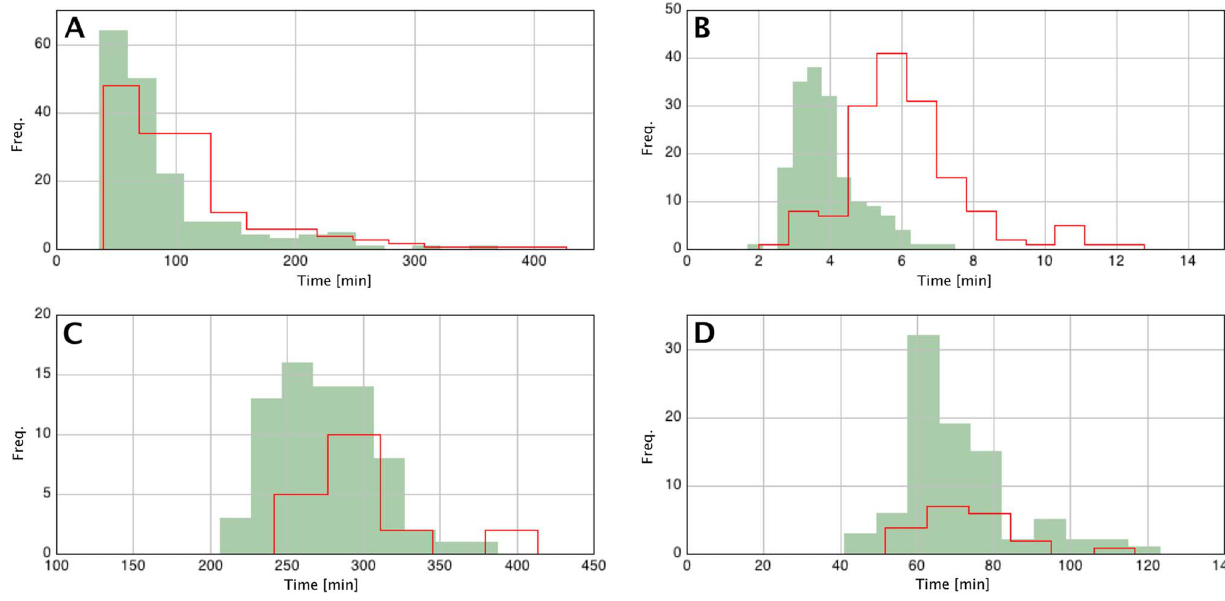
Figure 7. Analysis of individual spores with SporeTracker shows that germination and outgrowth times of heat-treated spores are affected. Movies of heat- (85 u C for 10 min) and un- treated spores (see Fig. 4 and 5 for details) were analyzed with SporeTracker. Frequency distributions of heat-treated and control spores were calculated and are shown in red (outline) and green (solid), respectively. Depicted are the frequency distributions of ( A ) the time to the start of germination, ( B ) the germination time, ( C ) the outgrowth time, and ( D ) the generation time of the outgrowing cells into a microcolony.